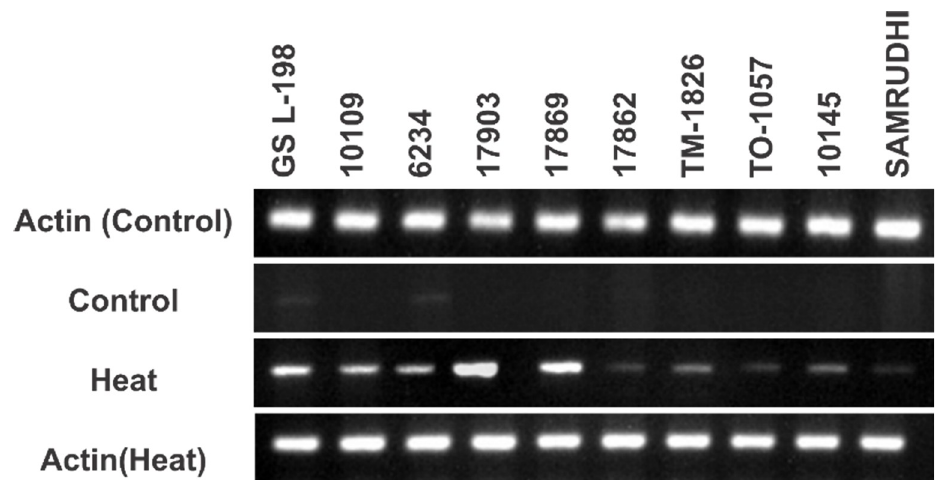
Fig 5. Expression profile of SlHsp100 gene in leaf tissues based on RT-PCR under heat stress (45˚C) and control conditions (25˚C). Actin was used as an internal control (top and bottom panel).